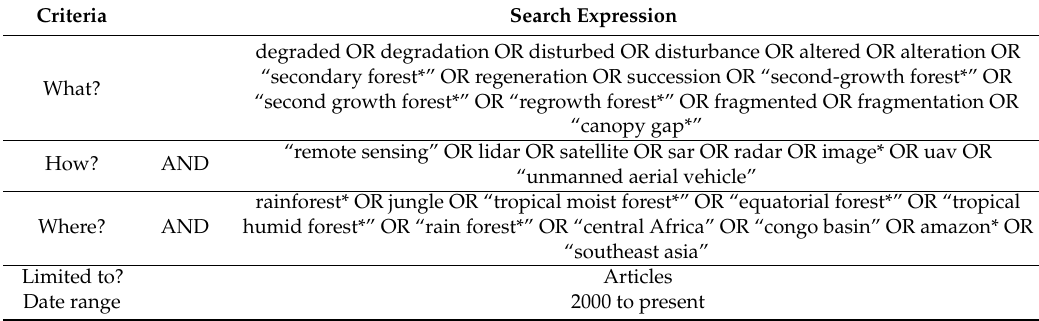
Table 1. Search expression encoded in Scopus database (March 2019) and applied to titles, abstracts and